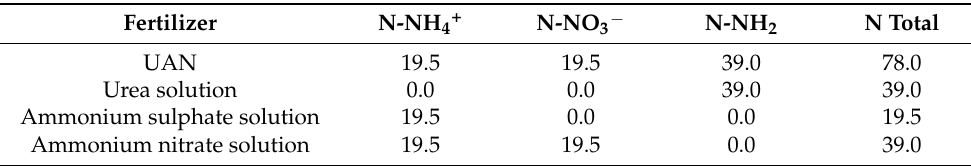
Table 3. Application dose of nitrogen ( µ g/hermetic chambers).